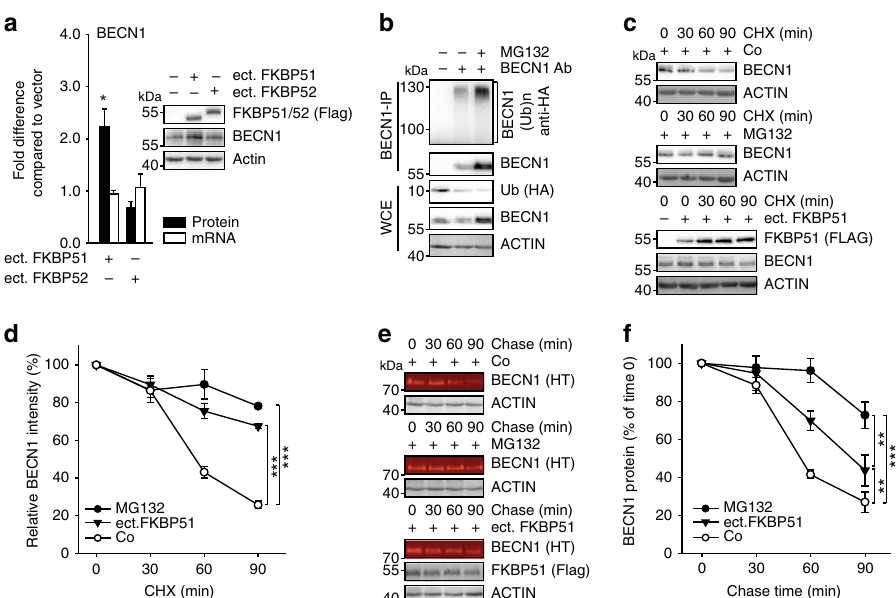
Fig. 1 FKBP51 increases BECN1 stability. a FKBP51 increases BECN1 protein levels. HEK293 cells were transfected with either Flag-tagged FKBP51 or FKBP52 expressing plasmid or control vector. BECN1 mRNA and protein were determined after 72 h. b BECN1 is subject to proteasomal degradation. HEK293 cells were transfected with Ubiquitin-HA expressing plasmid and treated with the proteasome inhibitor MG132 (10 µ M, 2 h) as indicated. BECN1 was immunoprecipitated from whole cell extracts and probed for ubiquitination by western blotting (quanti fi cation Supplementary Fig. 1a). c – f FKBP51 delays degradation of BECN1. HEK293 cells were transfected with vector control (Co) or FKBP51 expressing plasmid for 72 h and treated with the translation inhibitor cycloheximide (CHX, 30 µ g mL − 1 ) as indicated in c , d . In e , f , HEK293 cells were transfected with Halo-tagged BECN1 expressing plasmid together with FKBP51-Flag expressing plasmid or vector, cultivated with halogenated dye (100 nM, R110Direct, pulse) overnight, switched to medium without dye (chase) and treated with MG132 or vehicle for the indicated times. In all panels, error bars denote the standard error of the mean, derived from n = 3 biologically independent experiments. * p < 0.05, ** p < 0.01, *** p < 0.001 (one-way ANOVA in a, two-way ANOVA in d , f details in Supplementary Table 1). Source data and blot collections are provided as a Source Data fi FKBP51 with the USPs 18 and 36, and with the E3 ligase SKP2 by immunoprecipitation in HEK293 cells (Fig. 2a). TRAF6 that is known as an E3 ligase of BECN1 35 and interactor of FKBP51 36 served as a control. Of these FKBP51 interactors, SKP2, USP18